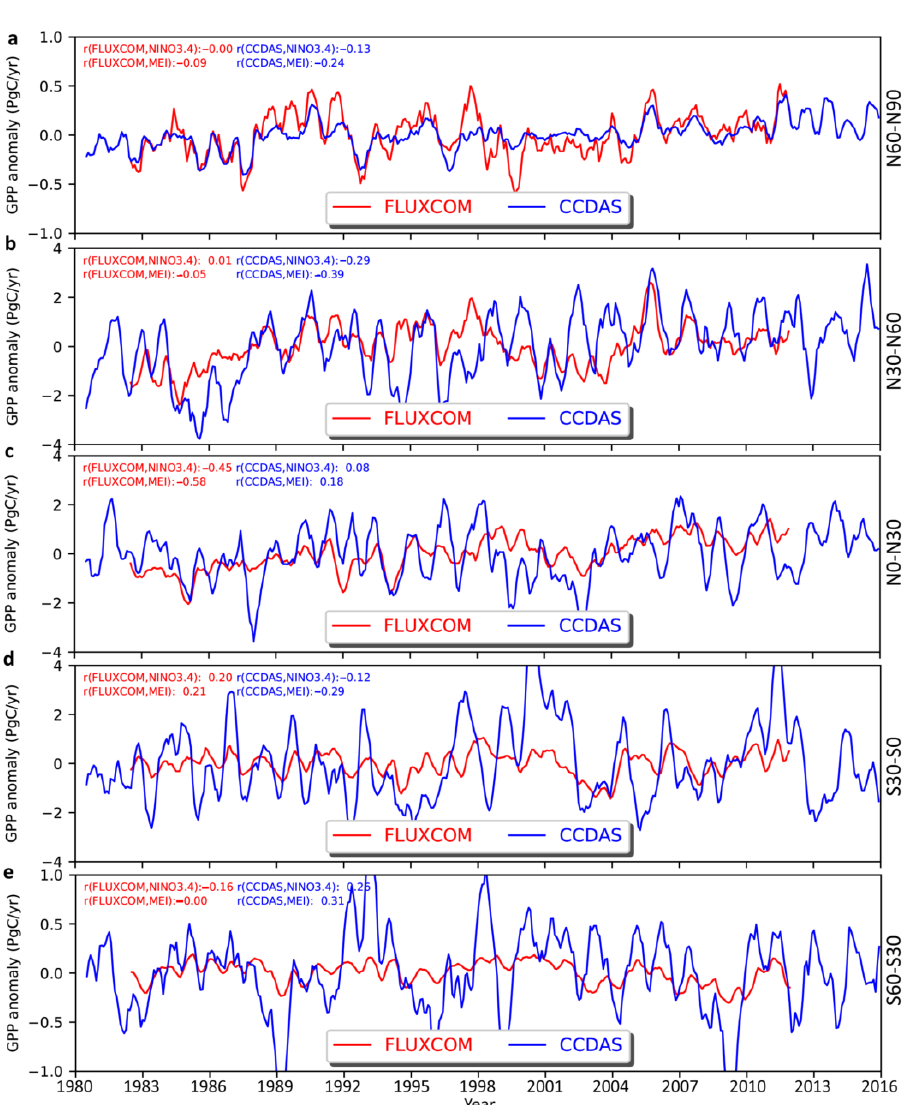
Figure A5. Time series anomalies of GPP from FLUXCOM and from CCDAS optimization (‘sm+co 2 ’) at various latitudes. ( a – e ) denote different latitudes. The anomalies are calculated from the mean GPP for each latitudinal band. Red lines for FLUXCOM and blue lines for CCDAS (‘sm+co 2 ’). The correlations of GPP anomalies and two ENSO indices (MEI and Niño 3.4) are depicted in each figure.